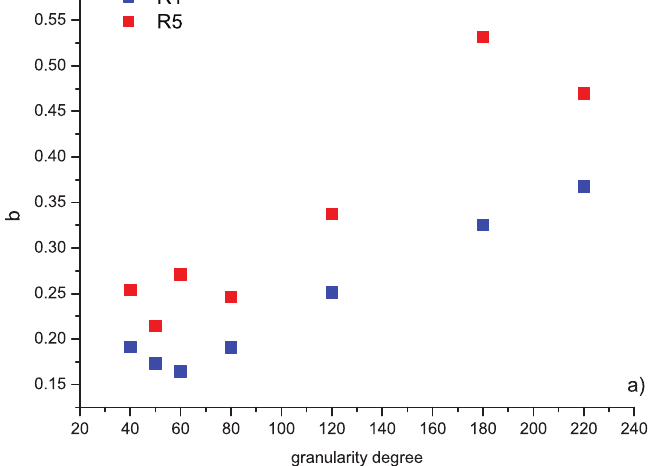
Figure 4. Relationship between the b -value, the run and the granularity degree of the aluminum track (the sandpaper coating the inferior surface of the moving block has granularity degree 36 in all the experiments). The first run is indicated by R1, while the fifth one by R5.